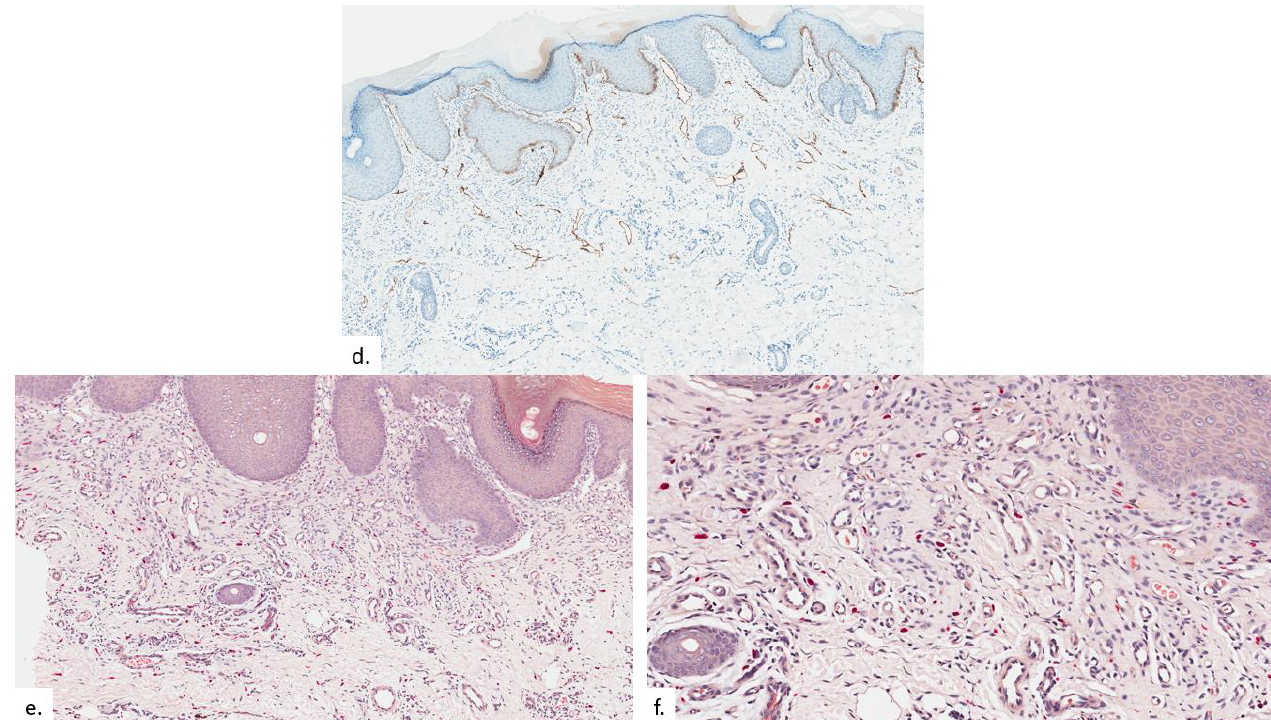
Figure 6. Patient 3. ( a ) There was compact hyperkeratosis and psoriasiform hyperplasia with hypergranulosis; ( b ) a vascular proliferation was present within the upper dermis; ( c , d ) the vascular proliferation consists of proliferation of capillary type vessels without endothelial cell atypia, with a modest increase in lymphatic channels on the podoplanin stain ( d ); ( e,f ) there were also increased quantities of MC on CAE.